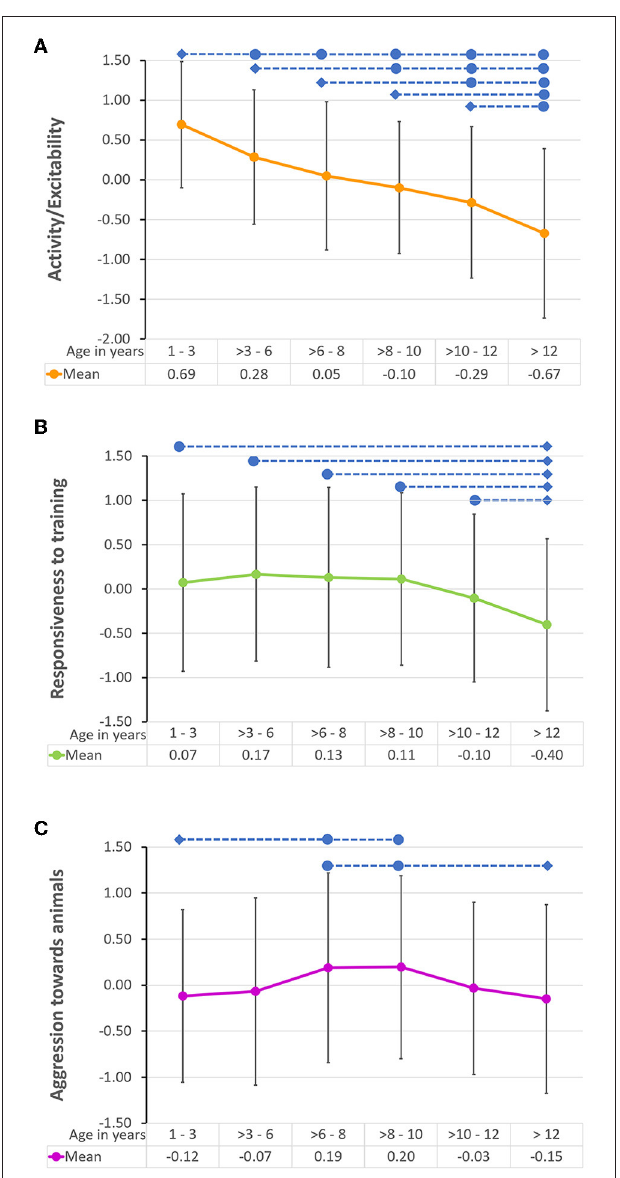
FIGURE 1 | Mean Z score (and standard deviation) of the Dog Personality Questionnaire (22) factors (A) Activity/Excitability, (B) Responsiveness to training, and (C) Aggression toward animals, in the six different dog age groups. The blue diamonds indicate the reference age group, and the blue circles and dotted lines represent significant differences between age groups p < 0.05 (after correction for multiple comparisons) in the pairwise post-hoc analysis. The mean Z score for each age group is presented under each